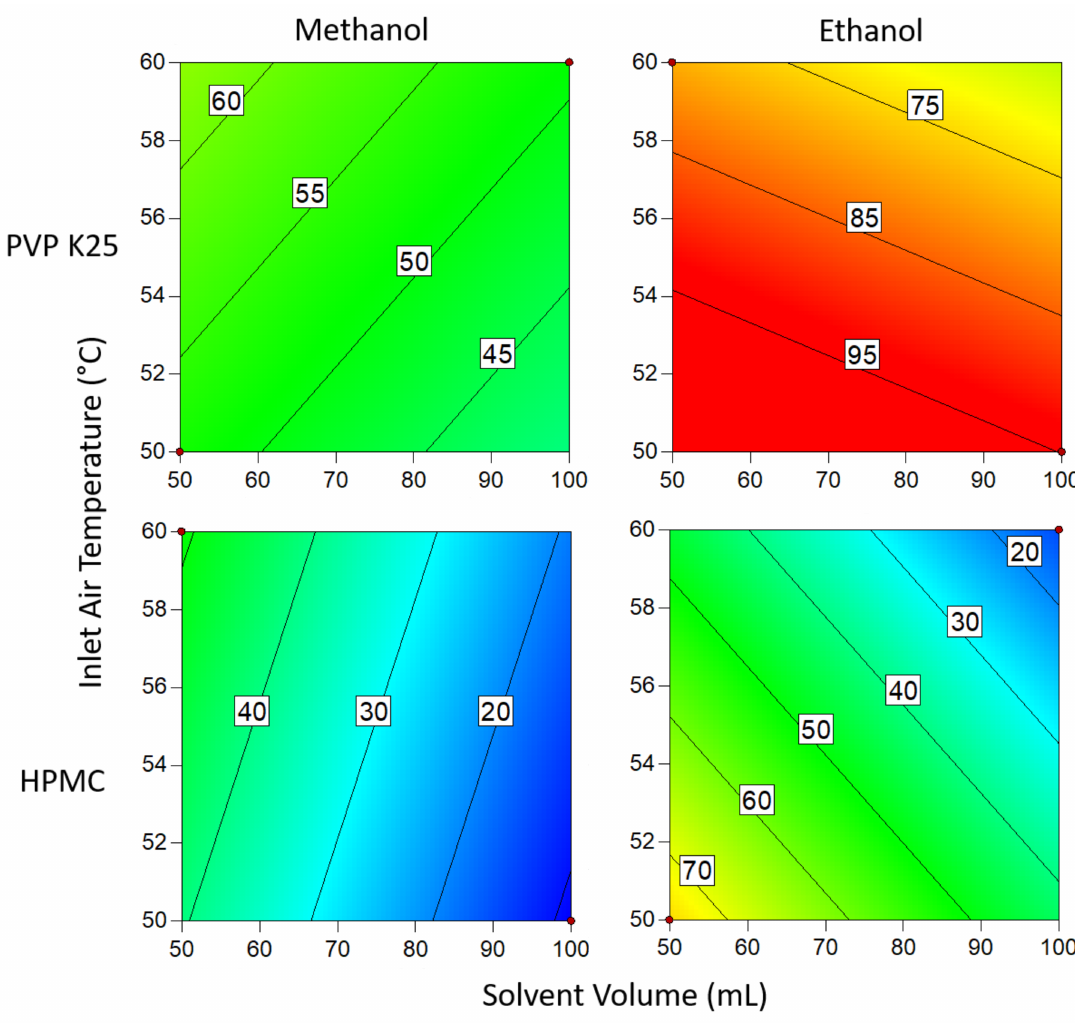
Figure 9. Degree of crystallinity when 1 g of binder is used. Numbers and tie lines correspond to points of equal DoC